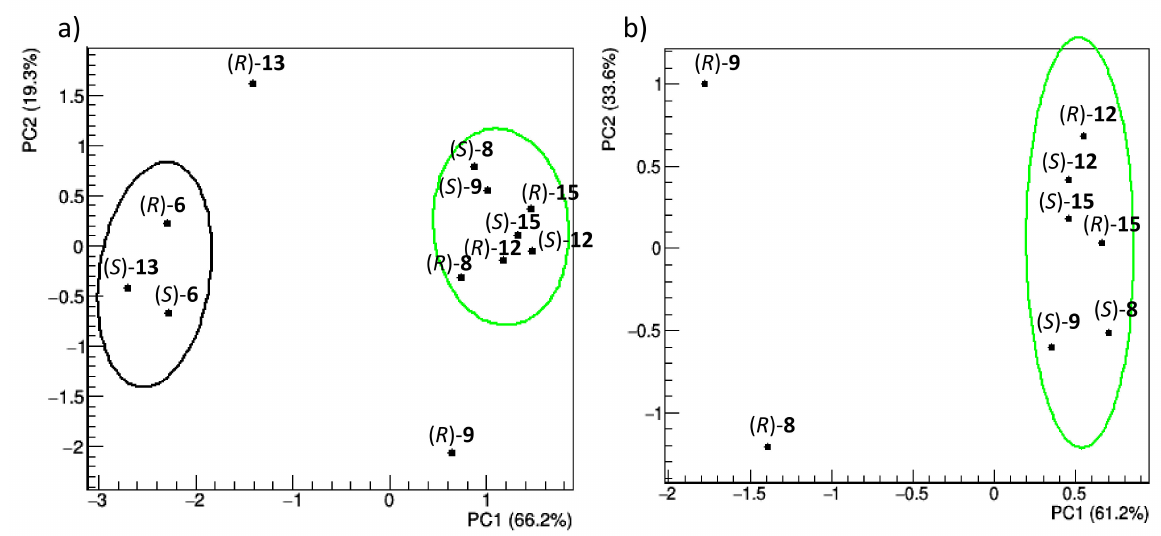
Figure 9. Score plots of the first two principal components obtained by PCA applied to RMSF profiles of the ( R ) and ( S ) enantiomers of racemic 6 , 8 , 9 , 12 , 13 , and 15 ( a ) and 8 , 9 , 12 , and 15 ( b ). Representative points of each enantiomer are grouped according to a hierarchic clustering algorithm; 85% confidence level ellipses are shown. The percentage of the data variance explained by each principal component is reported in parentheses on the